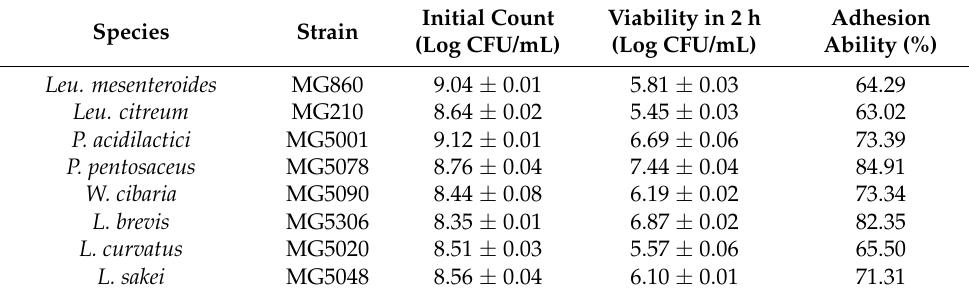
Table 3. Adhesion ability of the LAB strains on HT-29